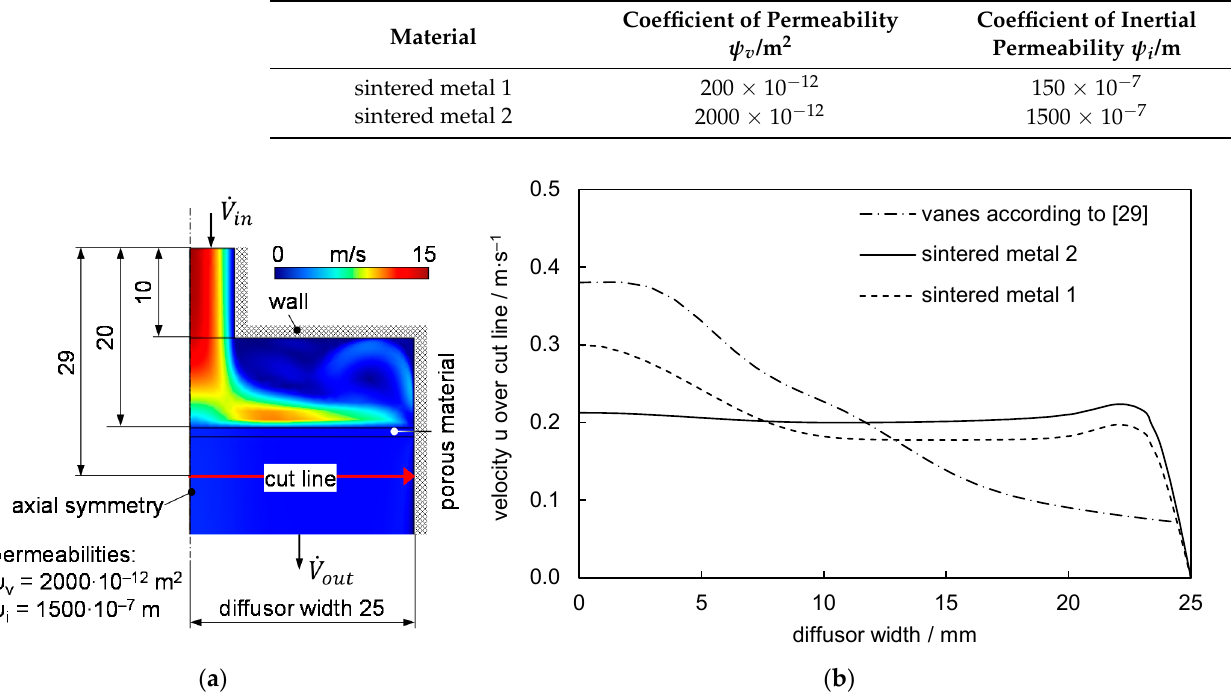
Figure 3. ( a ) magnitude of flow velocity for the sintered material (dimensions in mm); ( b ) effect of different diffusor designs on harmonization of flow velocity.